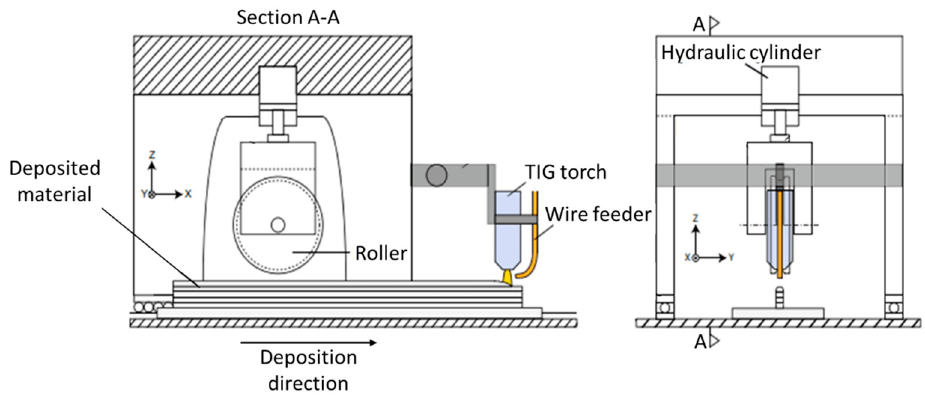
Figure 2. Schematic diagram of cold rolling WAAM process (adapted from [18]).